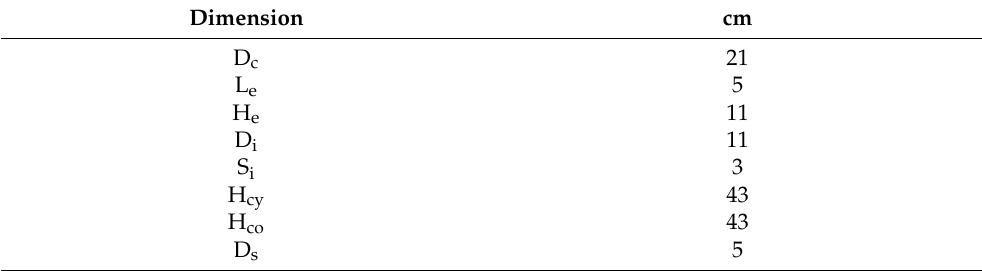
Figure 5. Proportions of a cyclone according to Duroudier [116]. Reproduced with the permission of ISTE Press Ltd. (London, UK) (Elsevier). Table 1. Dimensions of the cyclone according to Duroudier [116] .